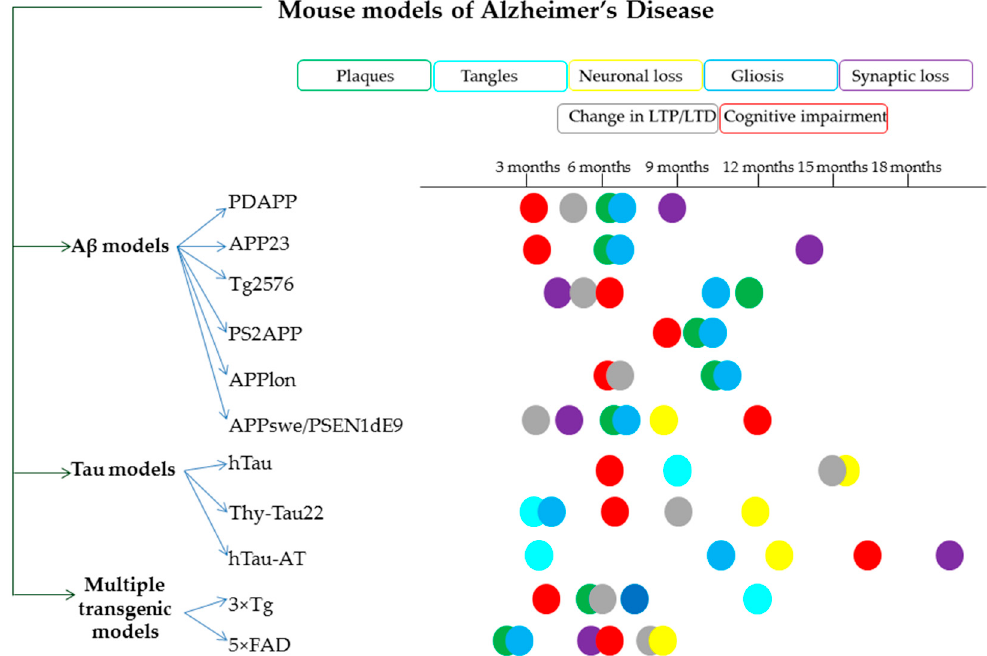
Figure 2. Schematic representation of the most common mouse transgenic models of Alzheimer’s Disease (AD) in association with their pathological changes and neurological deficits. A β models: PDAPP (hAPP695, 751 and 770 with Indiana V717F transgene, PDGF promoter), APP23 (hAPP751 containing the Swedish KM670/671NL transgene, Thy-1 promoter), Tg2576 (hAPP695 with Swedish transgene KM670/671NL, HamPrP promoter), PS2APP (hAPP695 with Swedish mutation KM670 / 671NL and PSEN2 with the N141I Volga German transgenes, Thy-1.2 promoter), APPlon (hAPP695 with Indiana mutation V717I, Thy1 promoter), APPswe/PSEN1dE9 (hAPP695 with Swedish mutation KM670/671NL, PSEN1:deltaE9 transgenes); tau models: hTau (human tau), Thy-Tau22 hTau (transgene containing the cDNA of the 412 amino acid isoform of human 4-repeat Table 272. V and P301S transgene), hTau-AT (hTau40 isoform 2N4R with the A152T transgene), and multiple transgenic models: 3xTg-AD (hAPP695 with Swedish KM670/671NL transgene Thy1 promoter; hTau with P301L, 0N4R mutation, Thy1 promoter;PSEN1 with M146V mutation, PS1promoter; 5xFAD (hAPP695 with Swedish, London and Florida mutations; PSEN1 with M146L and L28V mutations, Thy1 promoter). LTP, long-term potentiation; LTD, long-term depression of excitatory synaptic transmission.